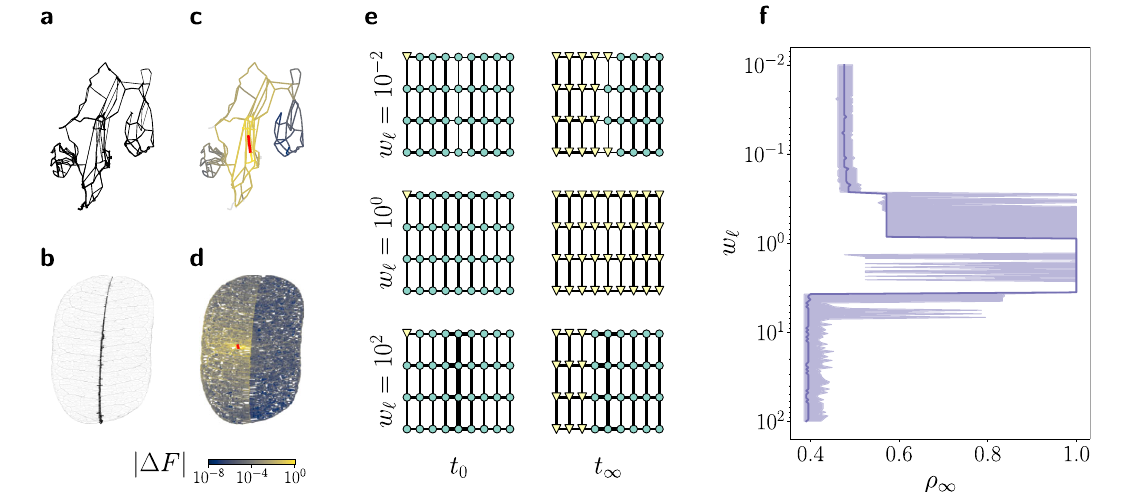
Fig. 1 | Different structural patterns separate networks and increase network robustness. a Topology of the Scandinavian power grid, with weak connectivity between different geographic units, in particular Finland. b Venation network of the leaf Schizolobium amazonicum , with a strong central vein separating the leaf into left and right. The width ofthe lines in a , b encodethe edgeweights. c , d Flow changes ∣ Δ F ∣ after the failureofa singleedge (colored inred) forthe two networks shownin a , b .Theimpactofthefailureisstronglysuppressedinanotherpartofthe network, i.e., in Finland and the right half of the leaf, respectively. This highlights the existence and impact of boundaries that separate the network into commu- nities. e Simulation of a classic model of global cascades 24,25 in a lattice with inho- mogenous edge weights. Edges in the middle have weight w ℓ (indicated by thin/